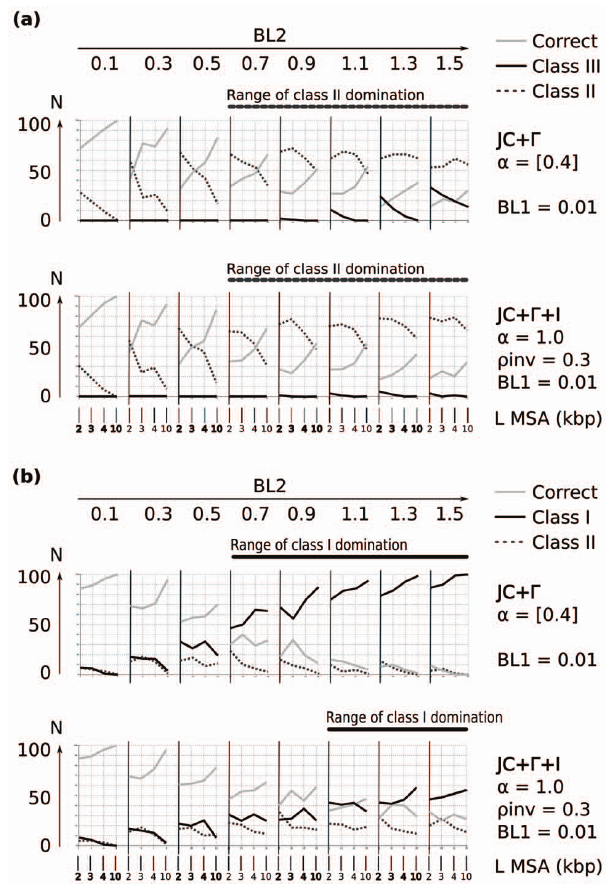
Figure 4. Occurence of long branch artefacts (LBA). Ranges of branch length differences between BL 1 and BL 2 (see Figure 2) in which LBA dominated tree reconstruction with investigated model assumptions in the majority of repeat steps, summarized over all alignment lengths. Dominated ranges of long branch artefacts are shown by bar charts. Single bars correspond to fixed ranges of lengths for BL 1 and BL 2 in which lengths of BL 2 increase from 0.1–1.5 within each box (x-axis; lower scale). Length of BL 1 increases with each box